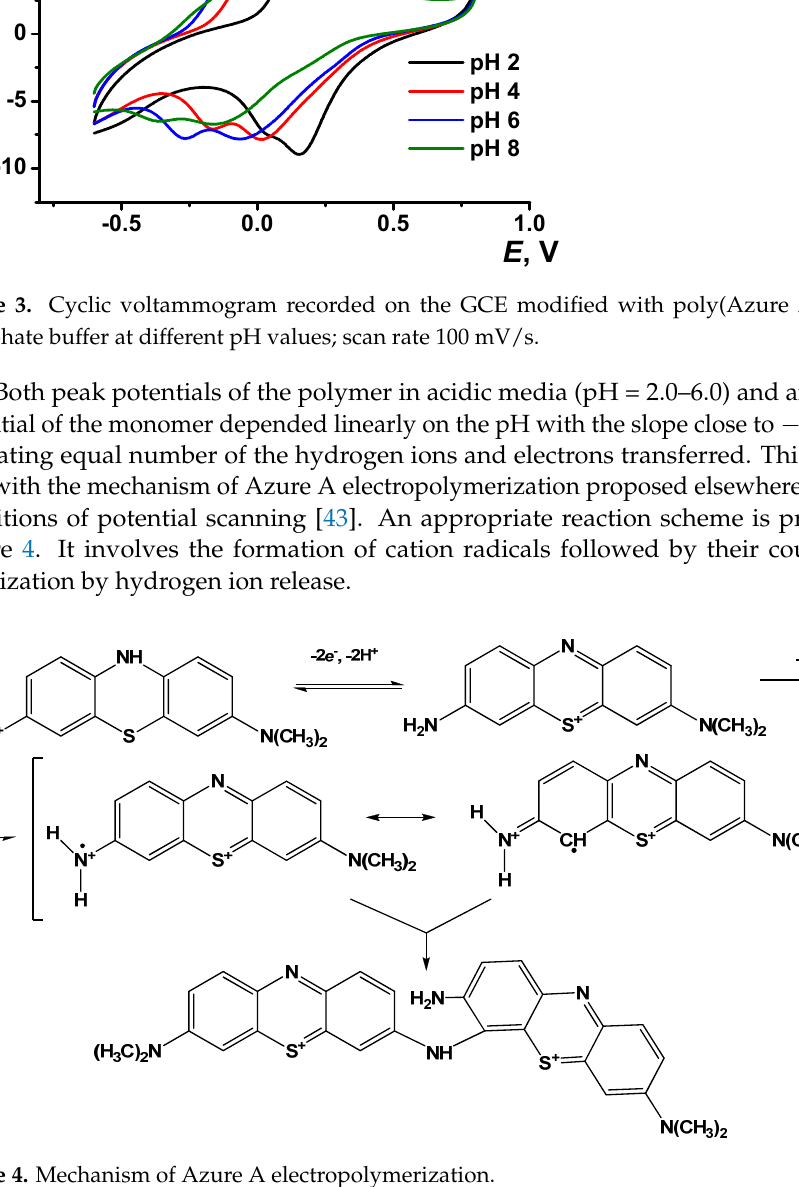
Figure 4. Mechanism of Azure A electropolymerization.